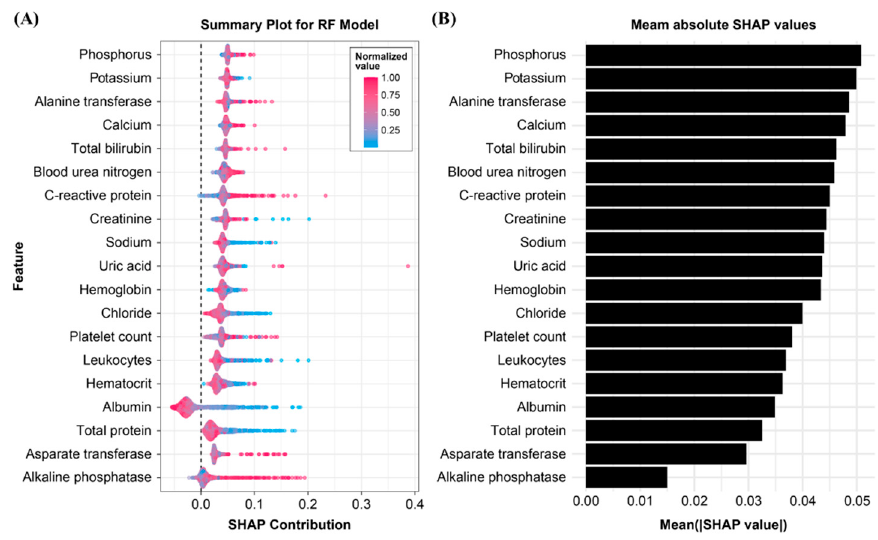
Figure 1. SHAP bee swarm plots and feature importance: ( A ) in the honey bee swarm plot, each point corresponds to a laboratory value observed in an individual person; ( B ) mean absolute SHAP values suggest a rank order for feature importance in the 30-day mortality.